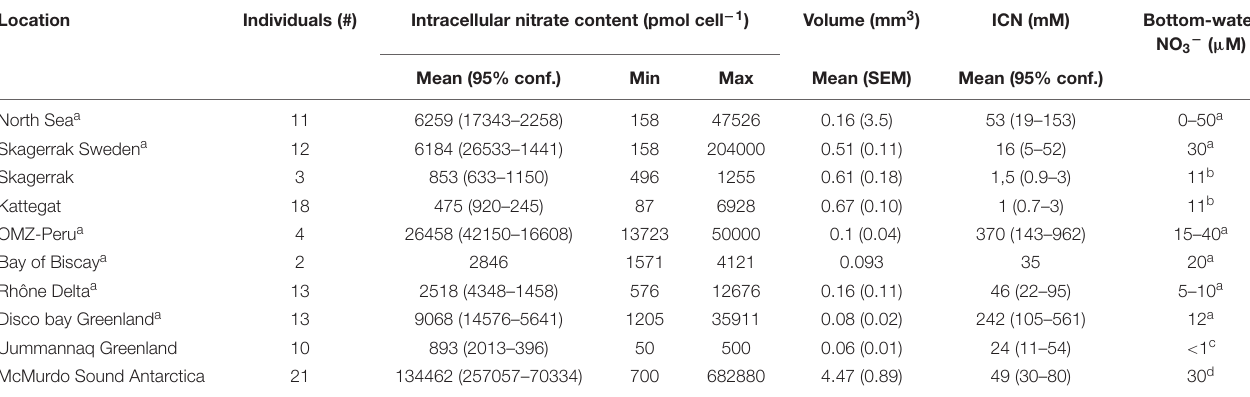
TABLE 1 | Intracellular nitrate content and concentrations in individual gromiids from different habitats, together with the bottom water NO 3 −